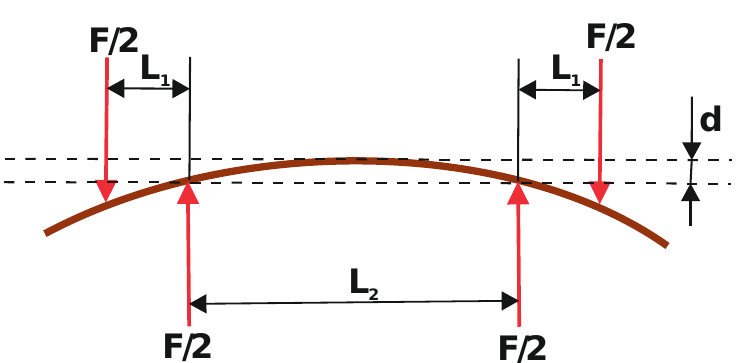
Figure 3. Loading scheme in 4-point bending test, F / 2—forces acting in supports, L 1 , L 2 —distance between supports, d—deflection arrow.